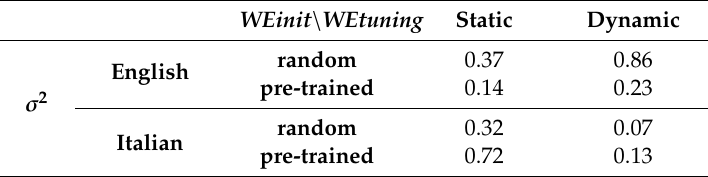
Table 4. Variance of testing accuracy over experiments repetitions 1